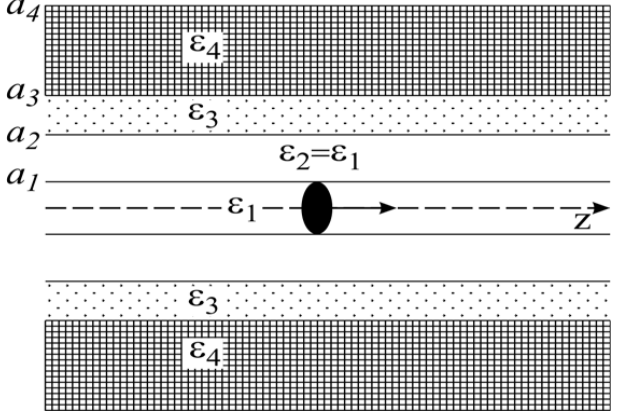
FIG. 1. Geometry of the